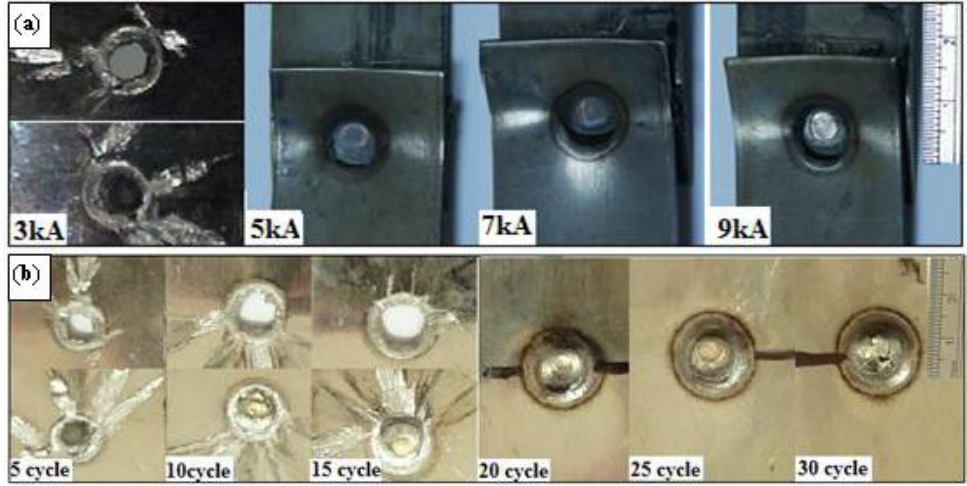
Figure 3. Failure mode of welded samples: ( a ) constant welding time for various welding currents; and ( b ) constant welding current for various welding times.